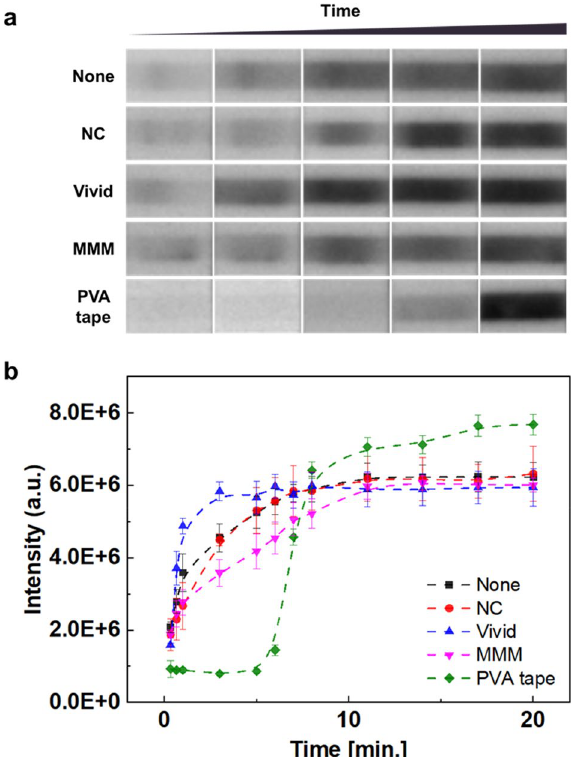
Figure 2. Delayed-release effect of the polyvinyl alcohol (PVA) tape compared with other membranes. ( a ) Time-dependent images obtained from assays. ( b ) Intensity plot. All images were obtained using a ChemiDoc XPS + imaging system (Bio-Rad), and the band intensities were measured using Image Lab software (version 6.1, https:// www. bio- rad. com/ en- uk/ produ ct/ image- lab- softw are? source_ wt= image labso ftware_ surl& ID= KRE6P 5E8Z). The error bars indicate the standard deviation from three independent